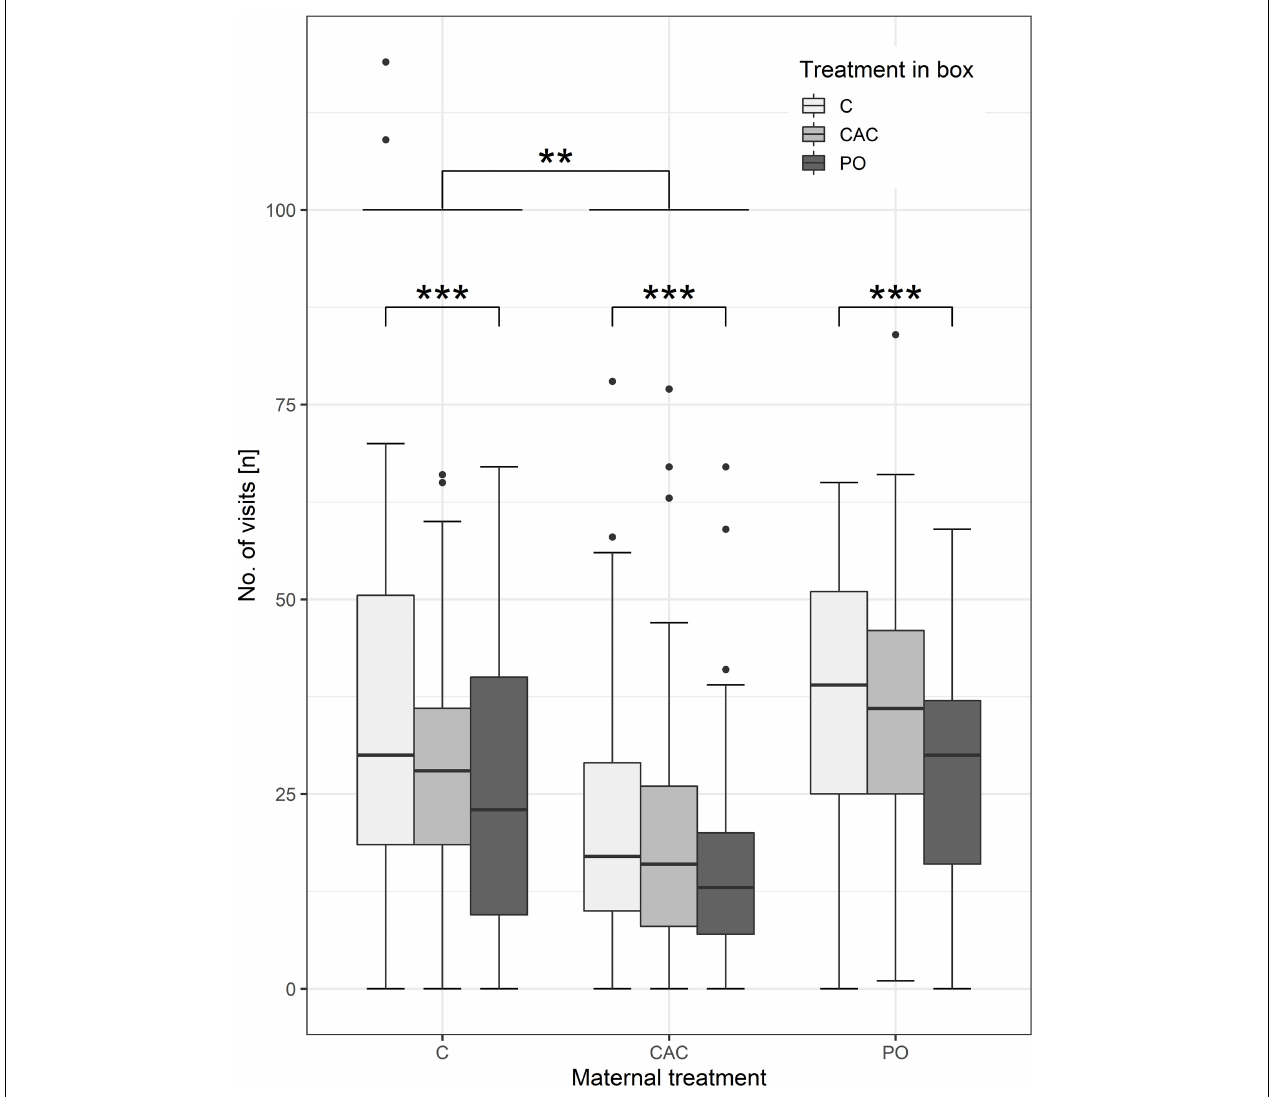
FIGURE 2 | Number of visits in the treatment boxes, split by maternal treatments. Asterisks indicate a significant difference from C at p < 0.01 (**) and p < 0.001